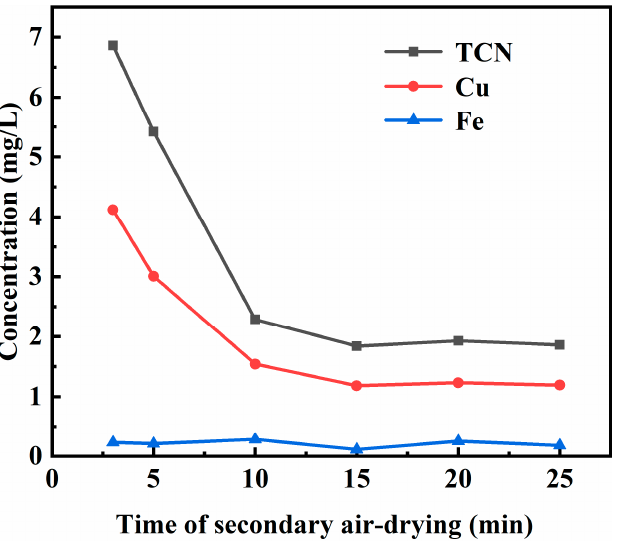
Figure 6. Effect of secondary air-drying time on the leaching toxicity of backwashed cyanide tailings.